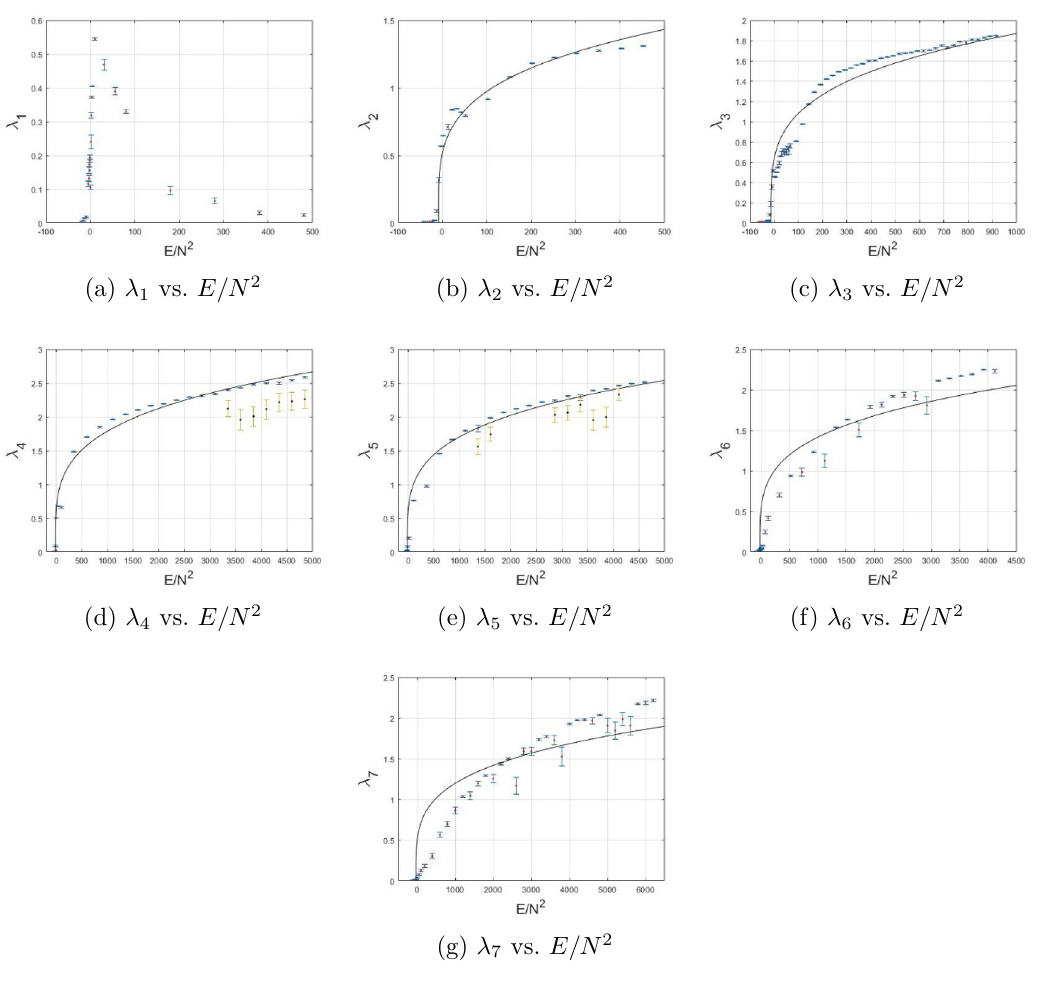
Figure 3. MLLE vs. E=N 2 for (cid:22) 2